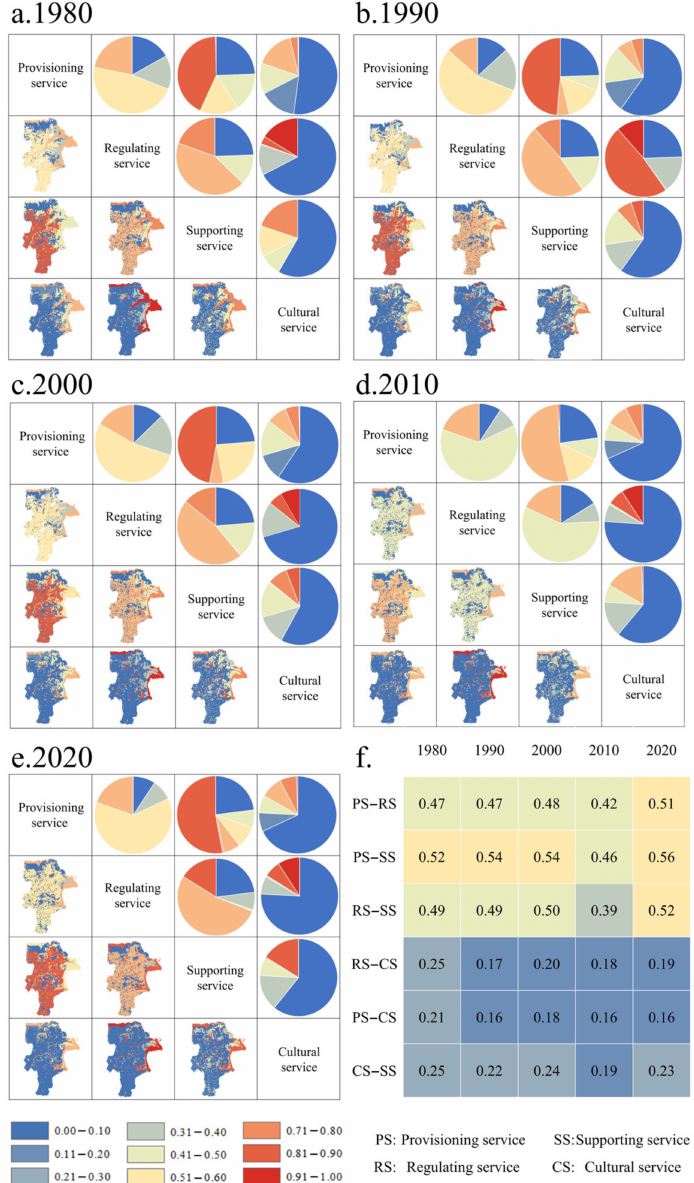
Figure 6. The coupling coordination degree (CCD) of ecosystem services (ESs) in the Yellow River Delta from 1980 to 2020. ( a – e ) The pie charts showed the area share of different CCD between ESs. ( f ) The temporal variability of mean value of CCD between